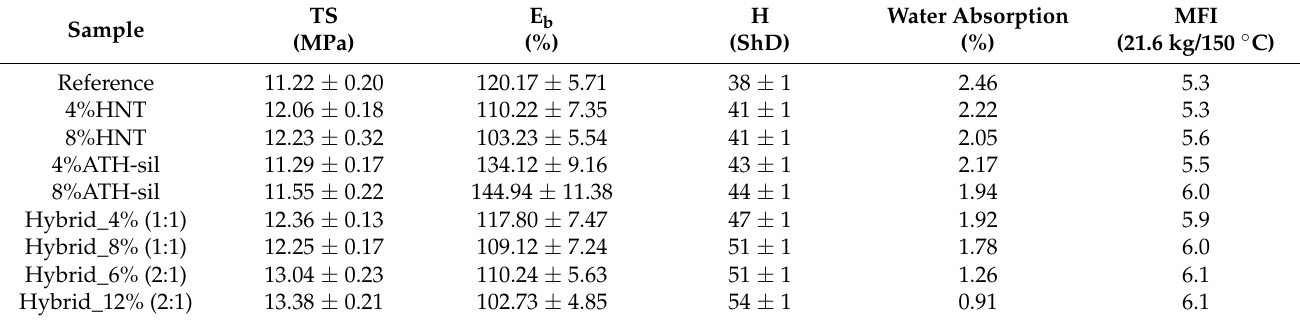
Figure 5. Representative stress–strain curves for the series of polymer compositions containing HNTs and/or ATH-sil. Table 2. Mechanical properties, hardness, water absorption, and MFI of EVA/LDPE and its nanocomposites.